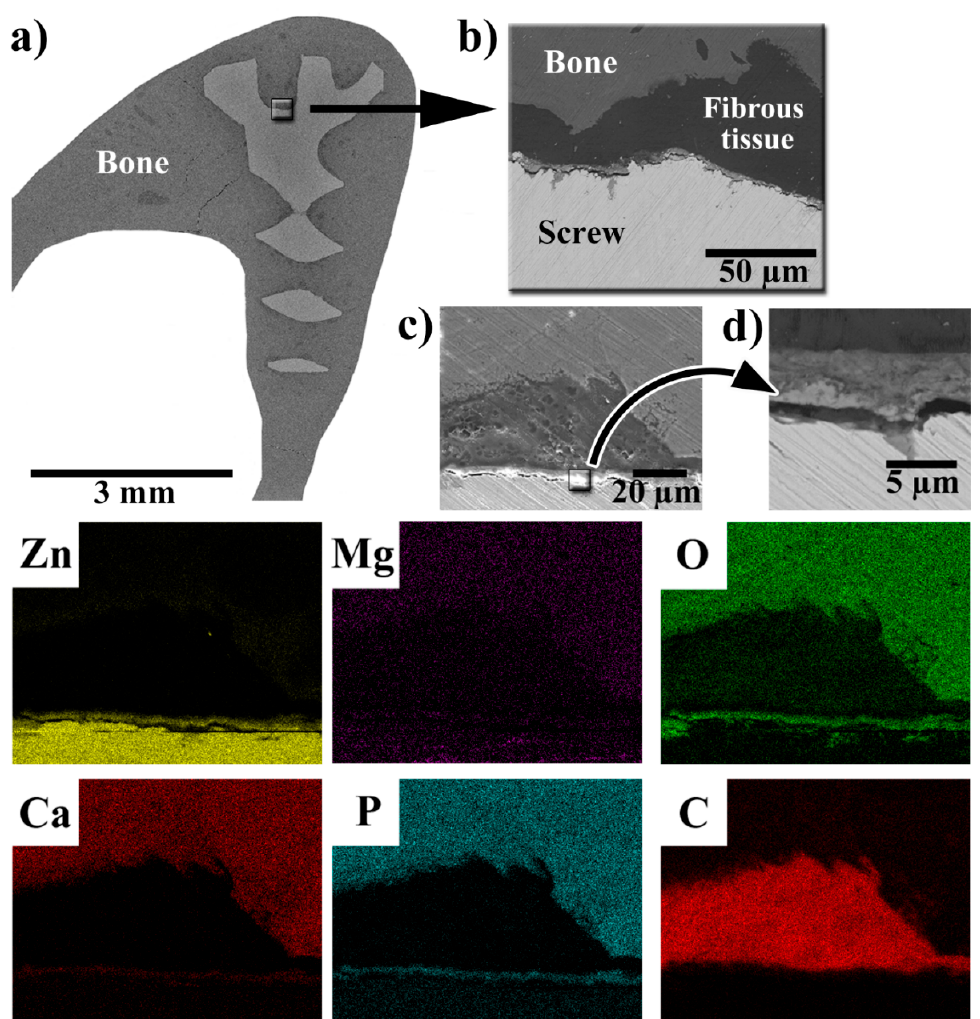
Figure 4. SEM-EDS observation of the bone section with the implanted screw. ( a ) SEM picture of the overview; ( b ) SEM picture of the screw–bone interface; ( c ) SEM picture of the area mapped via EDS (the elemental maps are shown below); and ( d ) a detailed view (SEM) of the layer of corrosion products.